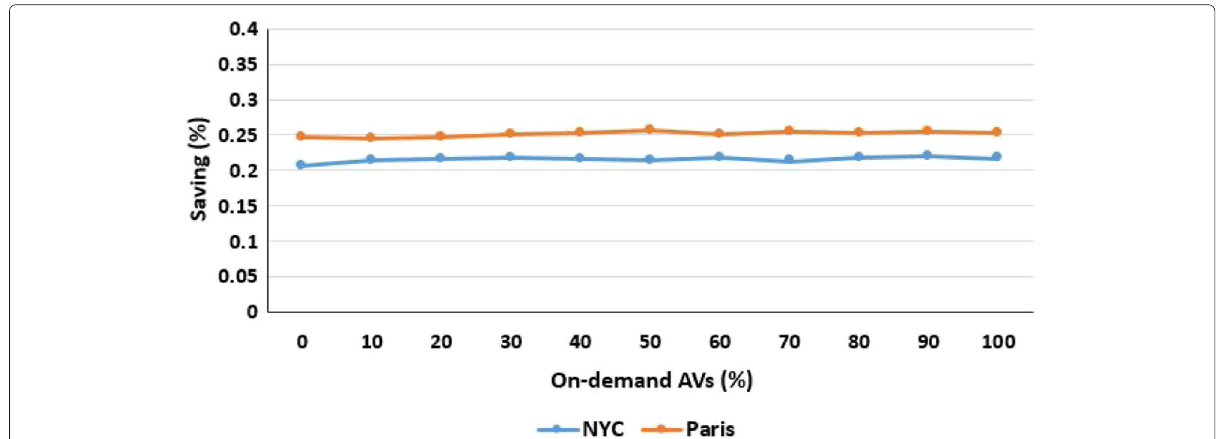
Fig. 13 Average Distance Saving